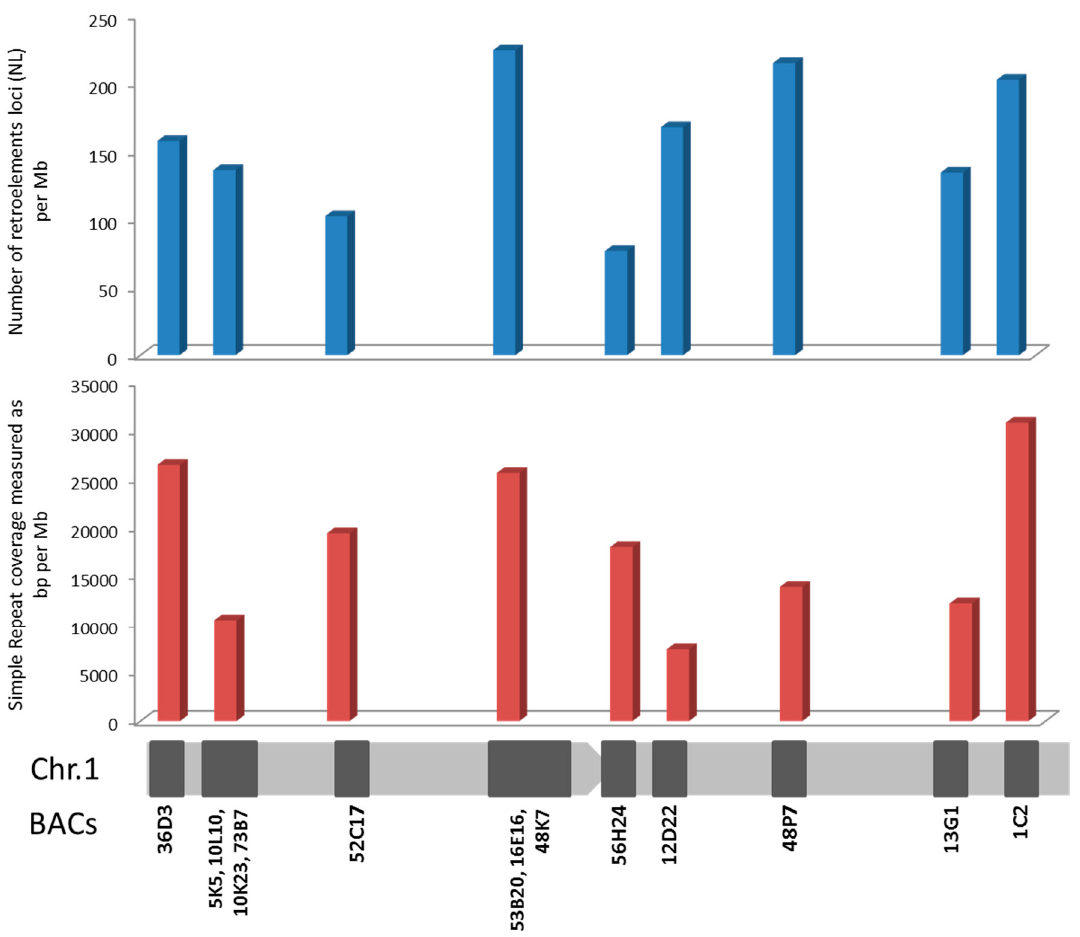
Figure 4. Repetitive elements distribution along S. senegalensis chromosome 1.